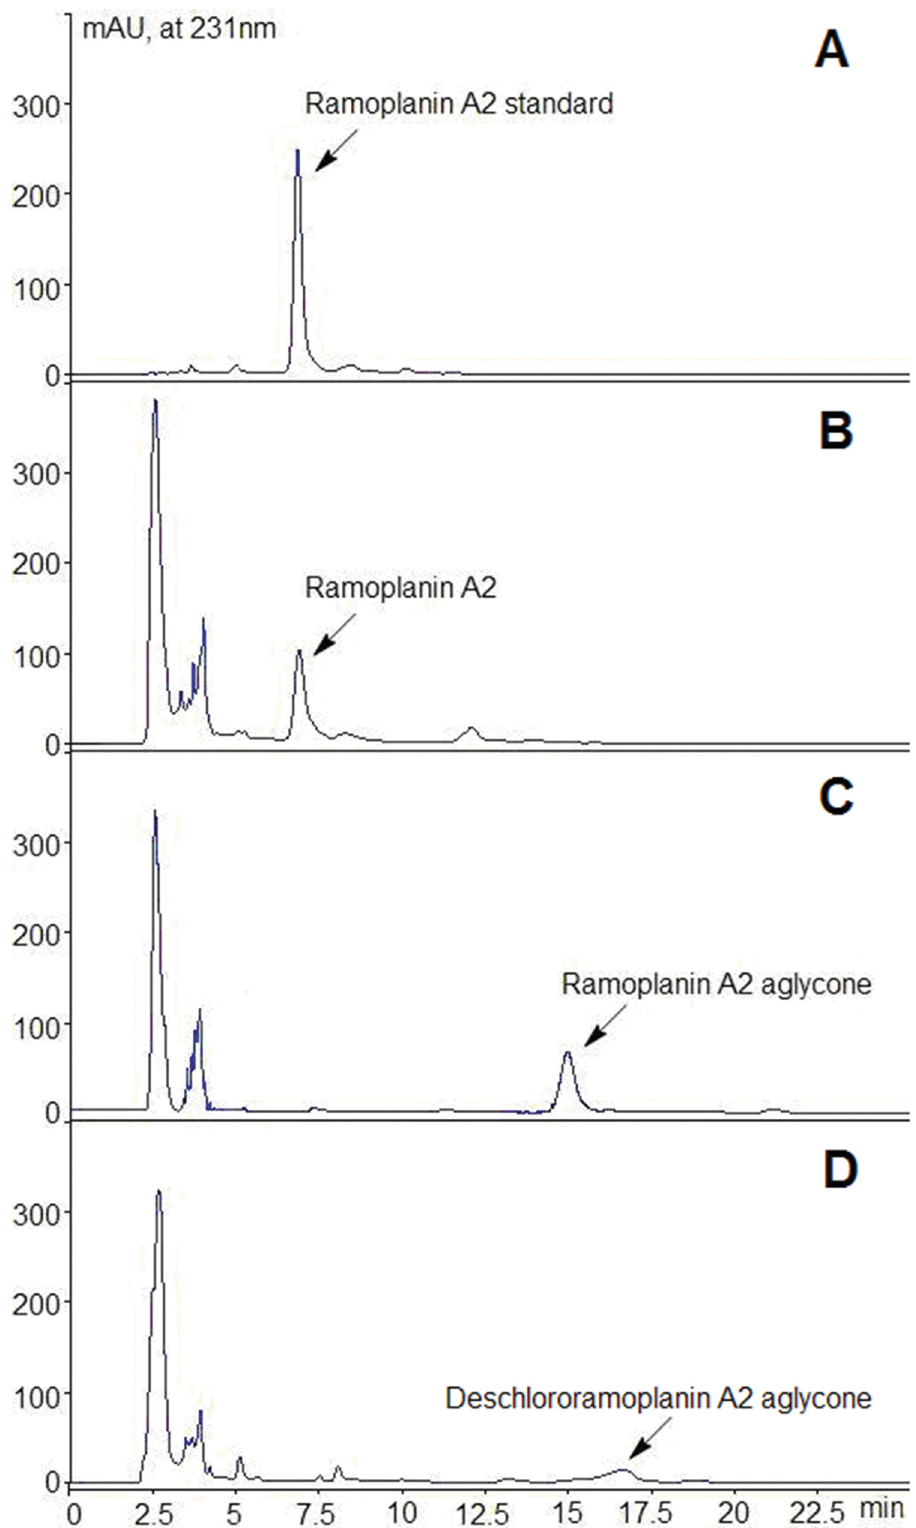
Fig 3. HPLC analysis of ramoplanin and its derivative. (A) Ramoplanin A2 standard; (B) Production of ramoplanin A2 in Actinoplanes sp . ATCC33076; (C) Ramoplanin derivative production in A . CJS1001 ; (D) Ramoplanin derivative production in A . CSL1015